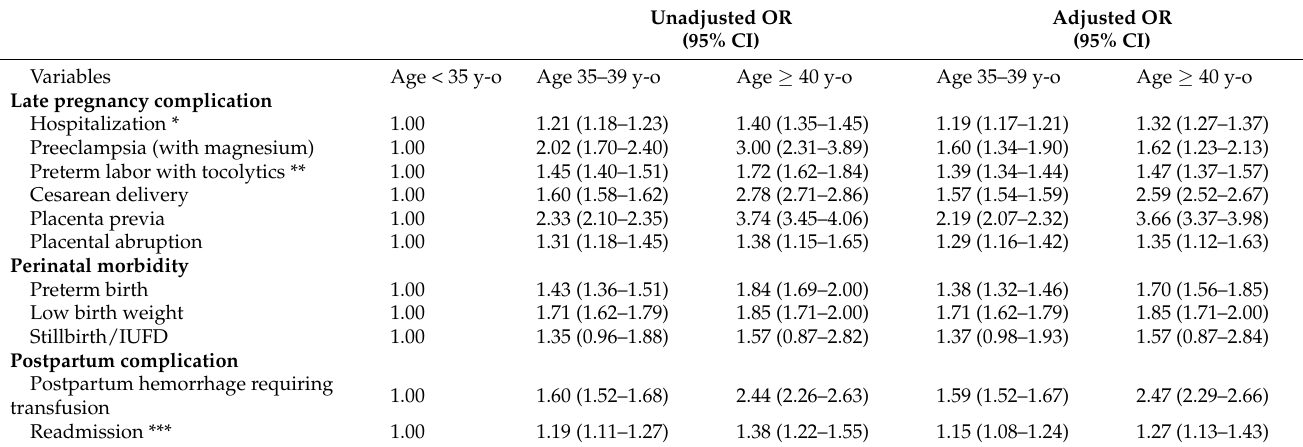
Table 3. Logistic regression for obstetric complications according to maternal